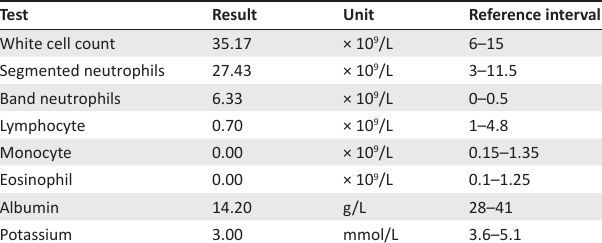
TABLE 1: Haematology and serum biochemistry